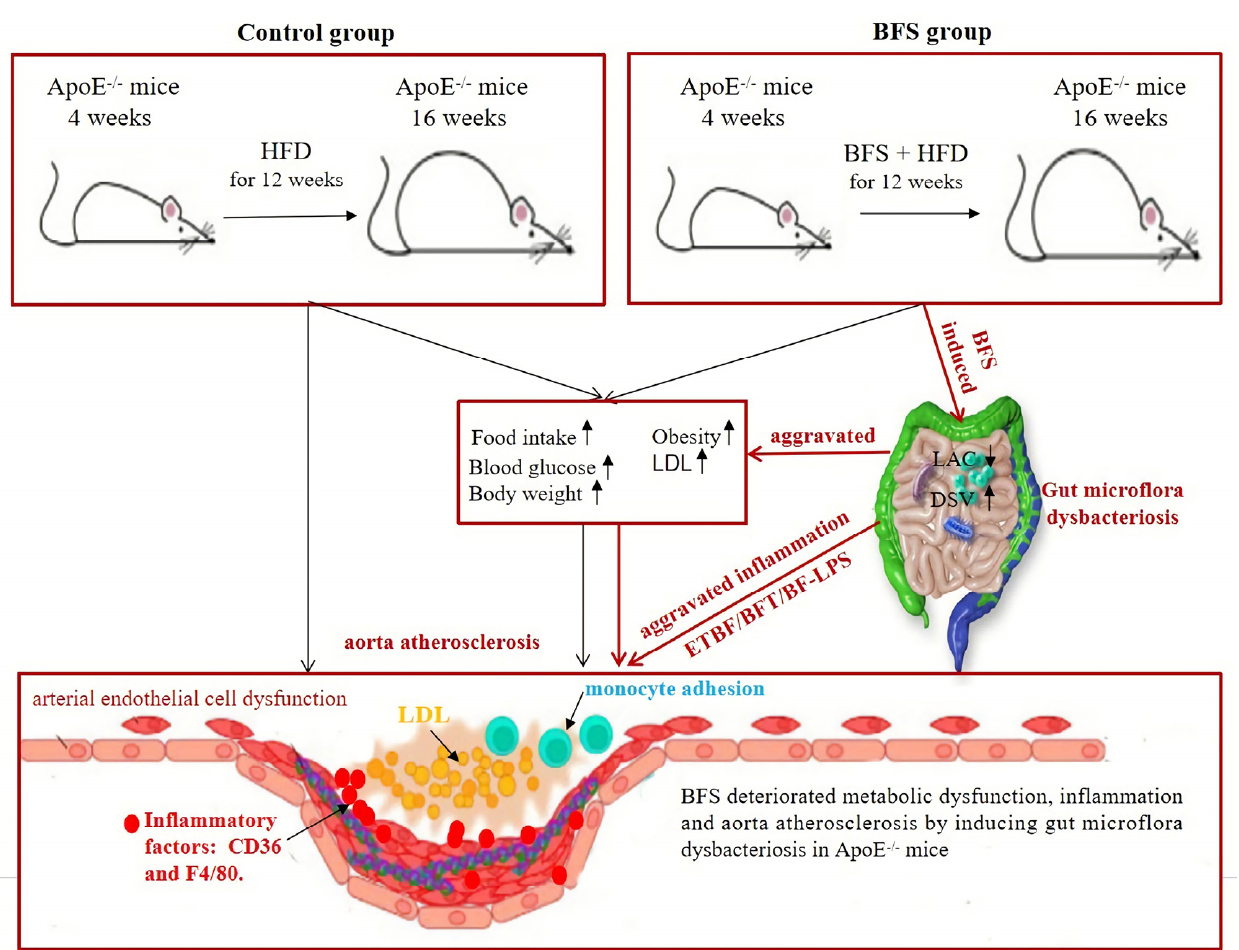
Figure 5. The deteriorating mechanisms of aorta atherosclerosis induced by Bacteroides fragilis supplementation. HFD: high-fat diet; BF: Bacteroides fragilis ; BFS: Bacteroides fragilis supplementation; LAC: lactobacillaceae ; DSV: desulfovibrionaceae ; IL-8: interleukin-8; LDL: low-density lipoprotein